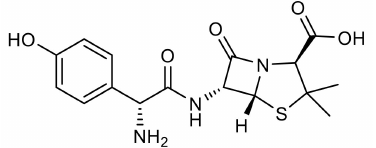
Figure 1. Chemical structure of amoxicillin